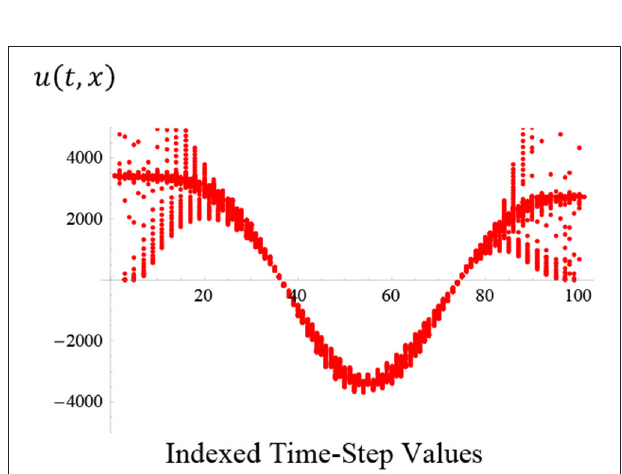
FIGURE 5 | Another exemplary sinusoidal solution, this time with increased frequency increased to ω ∼= 32.06, of the shock-wave of velocity, u ( t , x ) , again shown propagating with respect to the indexed time-step values up to 1s at the 100th position (or the 100th point on the graph). A sharper graph may be obtained by reducing not only the time-period, but also the time-step and the count for this scenario.